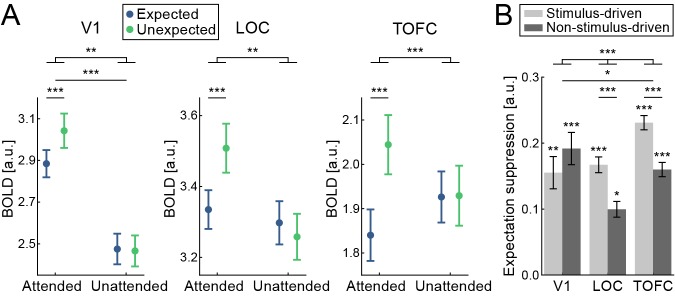
Expectation suppression within the ventral visual stream depends on attention.(A) Displayed are parameter estimates + /- within subject SE for responses to expected (blue) and unexpected (green) object stimuli during the objects attended task (attended) and objects unattended task (unattended). In all three ROIs, V1 (left), LOC (middle), and TOFC (right) BOLD responses were significantly suppressed in response to expected stimuli during the objects attended task. No difference was found between BOLD responses to expected and unexpected stimuli during the objects unattended task. The interaction effect between expectation and attention condition was significant in all three ROIs. (B) Expectation suppression in primary visual cortex is stimulus unspecific, and specific only in higher visual areas. Displayed is the average expectation suppression effect (BOLD responses, unexpected minus expected) split into stimulus-driven (light gray) and non-stimulus-driven (dark gray) gray matter voxels. Data are shown for the three ROIs, V1 (left bars), LOC (middle bars), and TOFC (right bars). Expectation suppression in LOC and TOFC was significantly larger for stimulus-driven than non-stimulus-driven voxels, while no such difference was evident in V1, indicating that expectation suppression in V1 was stimulus unspecific. Error bars indicate within-subject SE. Note, that the ROI masks in panel A and B differ, for details see: ROI definition and Stimulus specificity analysis in the Materials and methods section. *p<0.05. **p<0.01. ***p<0.001.10.7554/eLife.47869.003Figure 1—source data 1.Expectation suppression within the ventral visual stream depends on attention.The source data file contains a separate JASP file per ROI, containing BOLD data for expected and unexpected stimuli for both attention conditions (objects attended and unattended tasks; Figure 1A). Also contained is a JASP file showing expectation suppression per ROI split into stimulus driven and not stimulus driven voxel (Figure 1B).